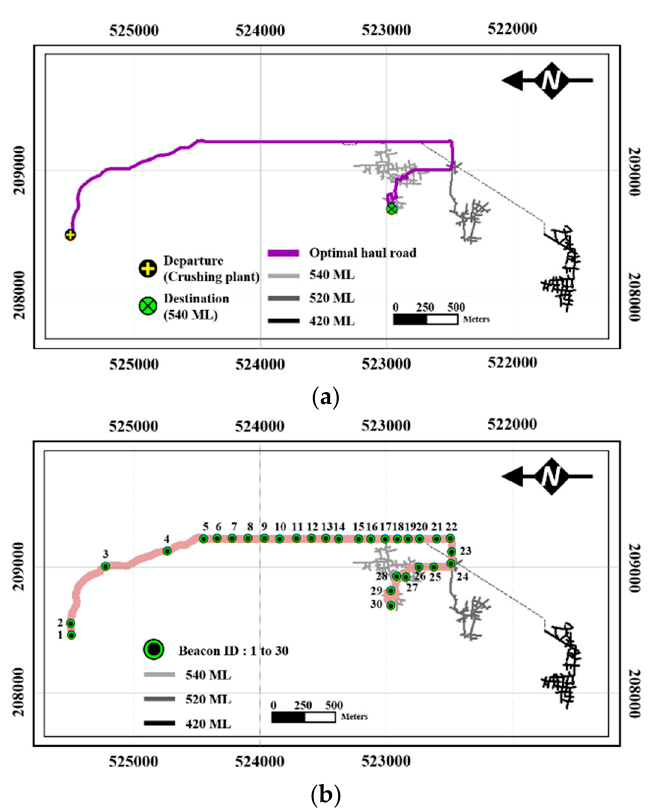
Figure 7. ( a ) Optimal haul road connecting the crushing plant and 540 ML workplace; ( b ) Bluetooth beacons that installed along the optimal haul road.